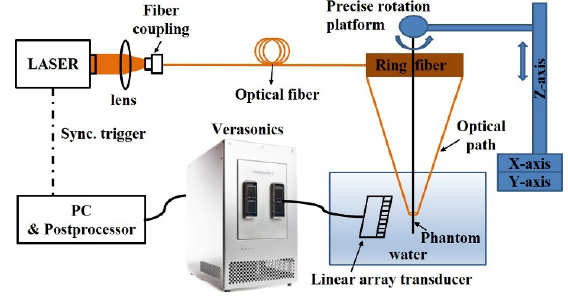
Fig. 3. The experiment setup of synthetic aperture